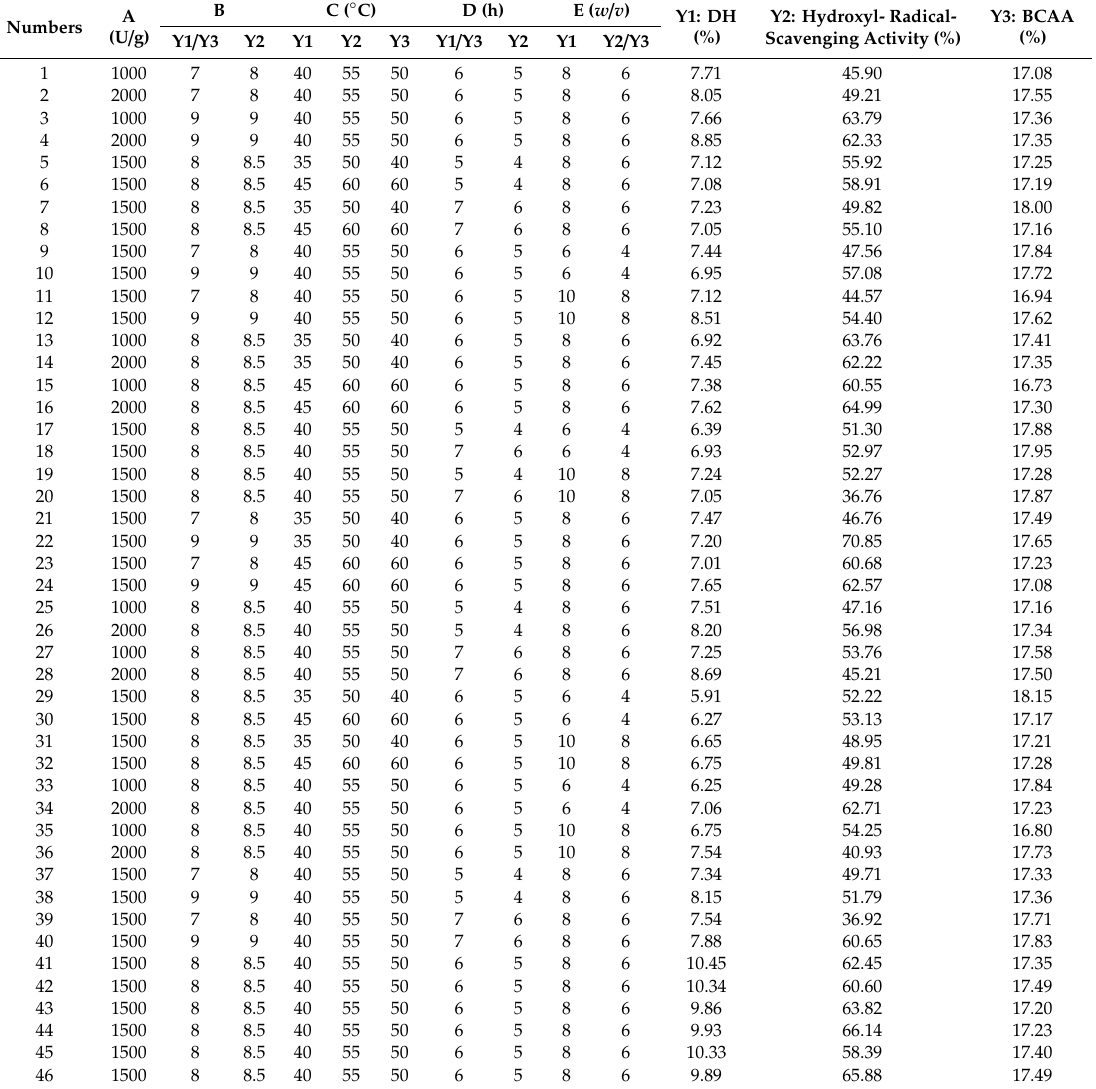
Table 2. Experimental design and result of di ff erent response